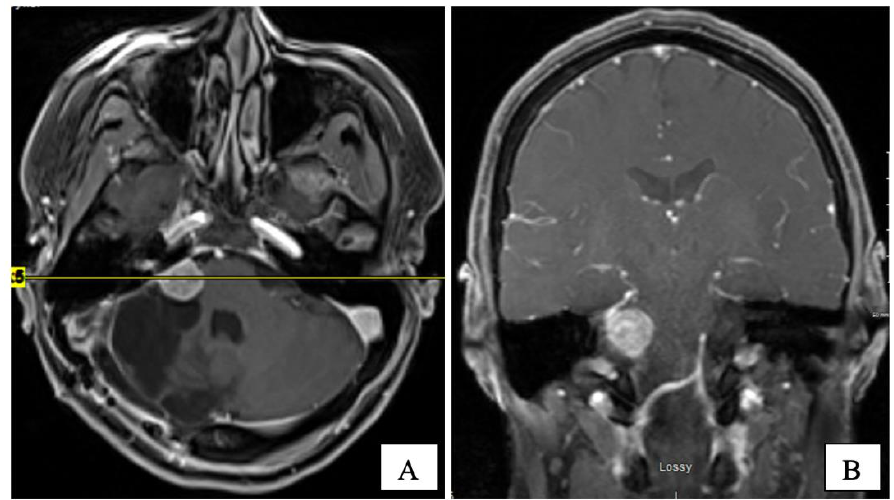
Figure 3. T1-W post-gadolinium MRI at 7 years post-op on axial ( A ) and coronal ( B ) planes. The CPA tumour measured 16 × 15 × 17 mm.